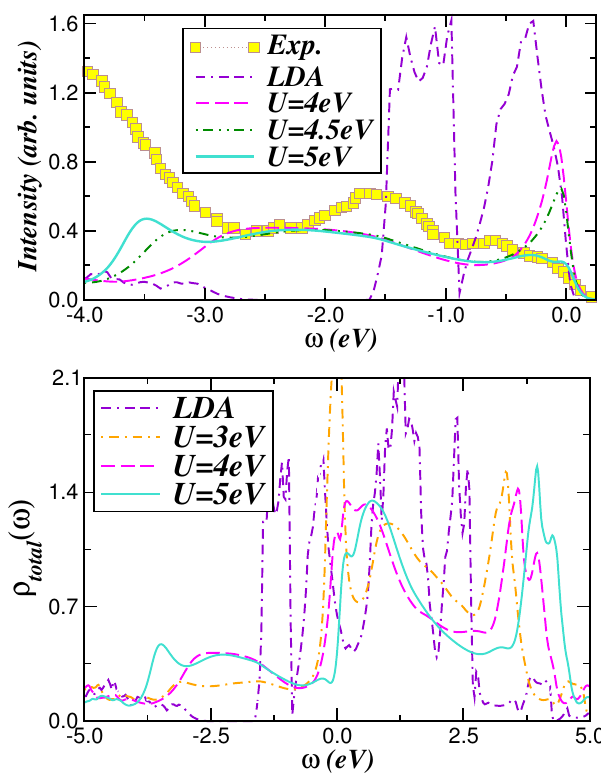
Figure 4. Bottom panel: Role of electron–electron interactions on the total LDA+DMFT DOS. LDA results are shown for comparison. Notice the formation of a lower Hubbard band at energies close to − 2 eV and the evolution of the reconstructed electronic structure above E F . The top panel shows the theory-experiment comparison between LDA+DMFT one-particle spectral functions and the photoemission spectra taken from Ref. [19]. Notice the good theory-experiment agreement at low energies and the correlation induced transfer of spectral weight compared to LDA from low to high binding